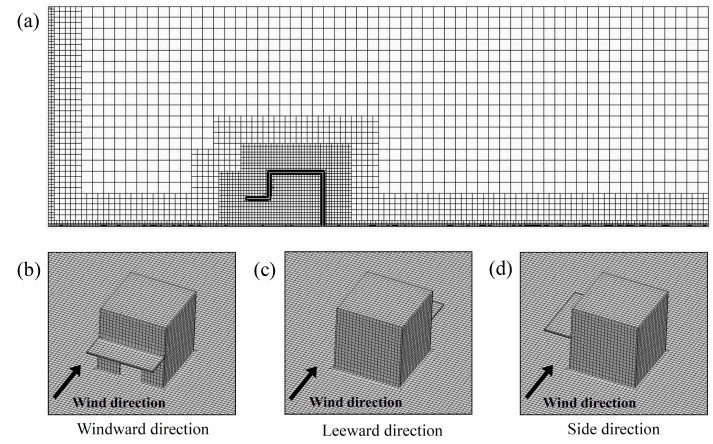
Figure 2. ( a ) Unstructured hexahedral grid (420,000 cells) on the vertical plane at the center of the building and the wind directions for the building; ( b ) windward; ( c ) leeward; and ( d )